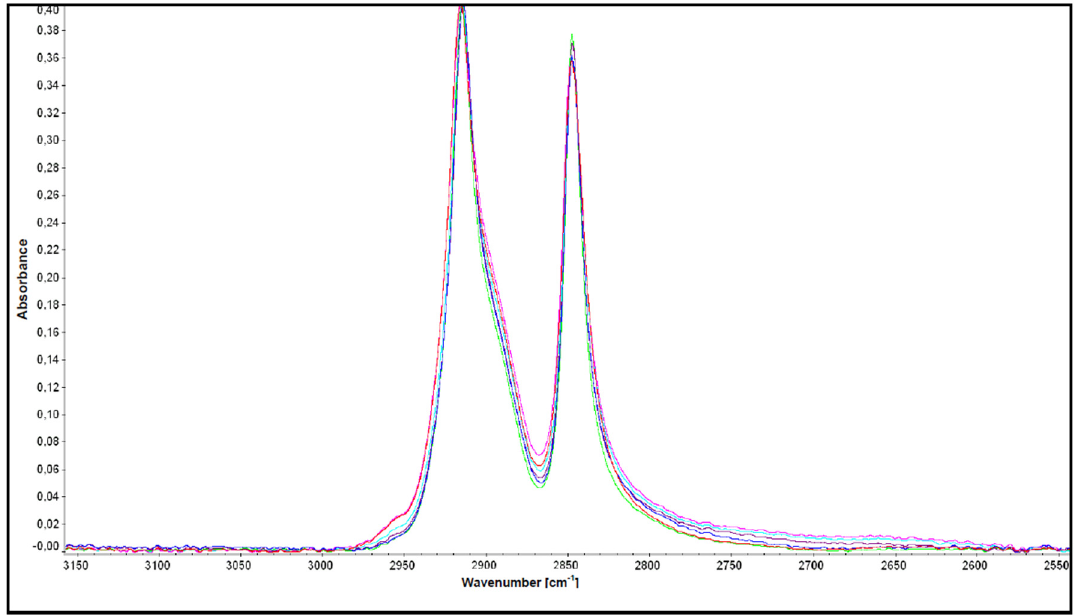
Figure 8. Collected FT-IR spectra (2750–3000 cm − 1 region) of virgin geogrid samples and aged geogrid samples (Radiowo).